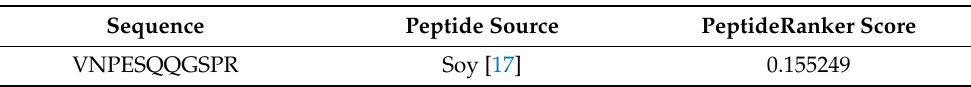
Table 2. Medium-sized peptide identified in fraction 3 that matched with a BIOPEP-UWM sequence validated for antioxidative